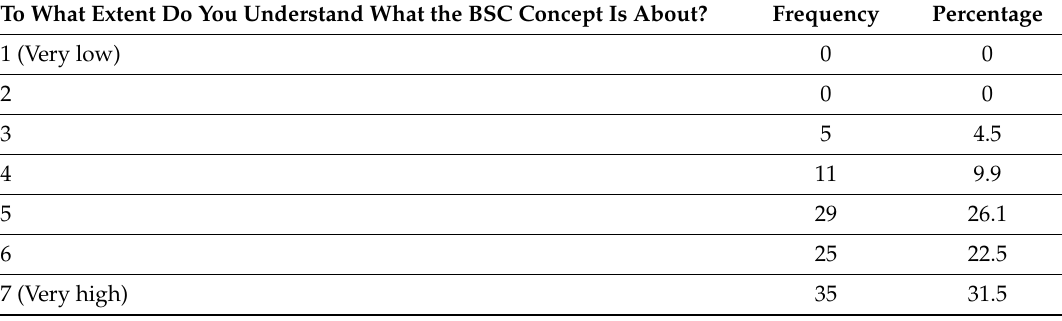
Table 5. Perceived understanding of the BSC (N = 105).